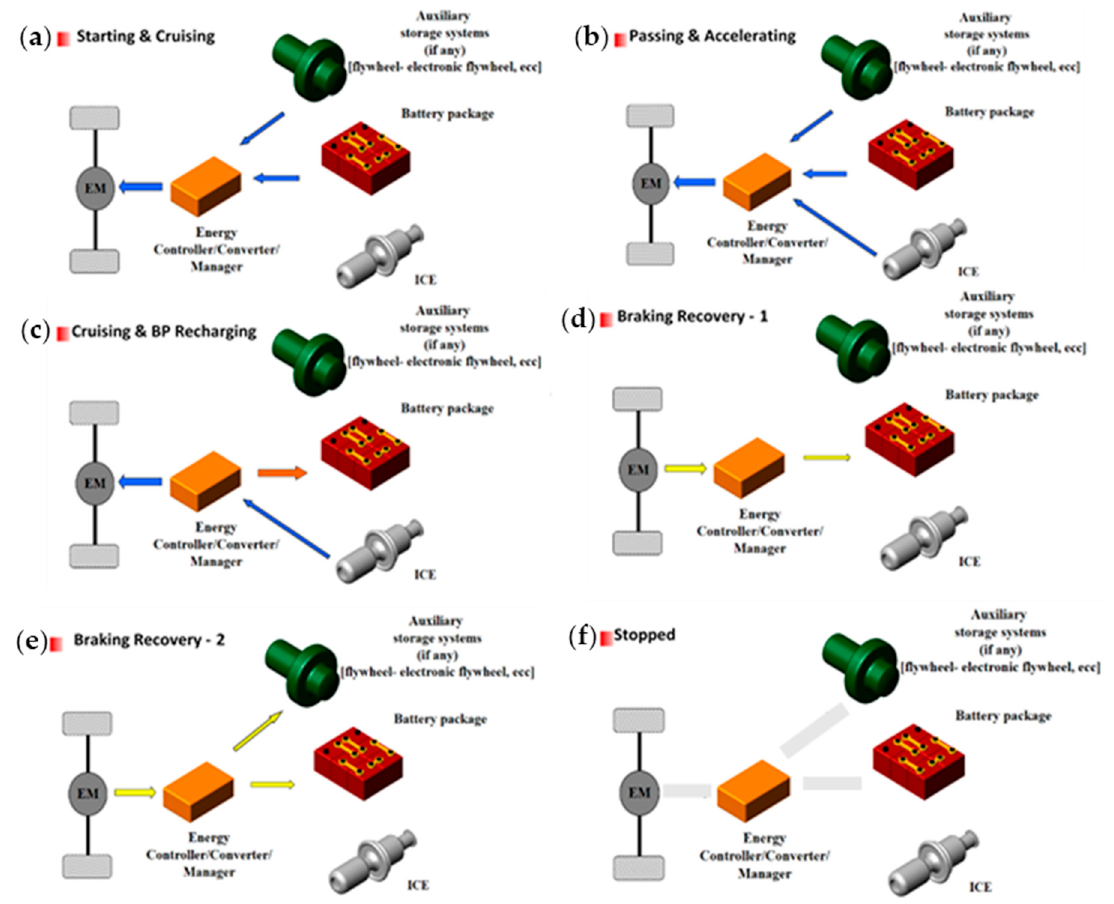
Figure 3. Basic Operation Modes of Hybrid Vehicles: ( a ) starting and cruising; ( b ) acceleration; ( c ) cruising and battery recharging; ( d ) braking; ( e ) second braking recovery mode; ( f ) stop.